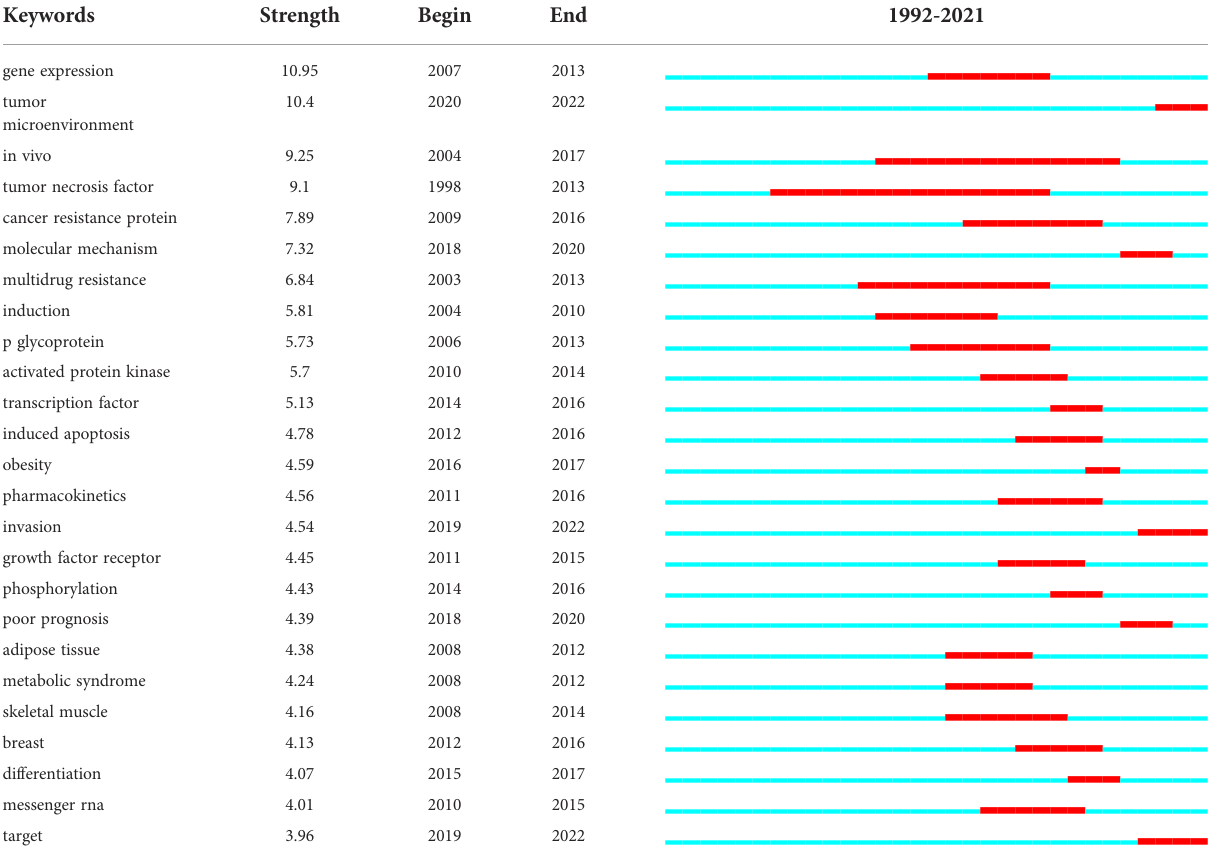
TABLE 3 Top 25 keywords with the strongest citation